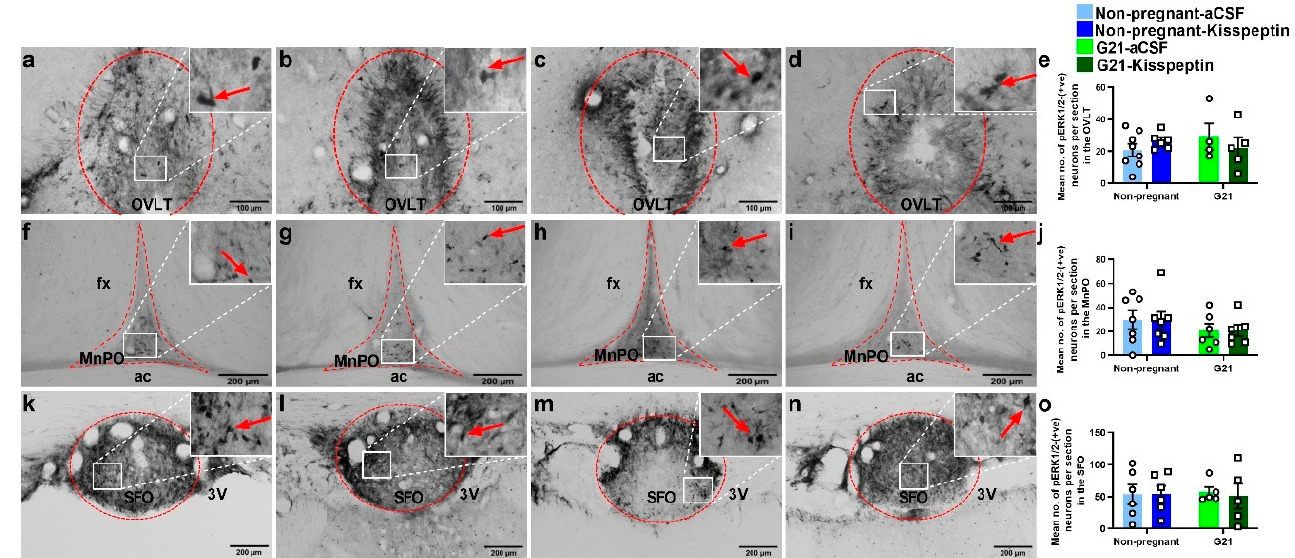
Figure 7. Kisspeptin does not affect pERK1/2 expression in OVLT, MnPO or SFO neurons of non- pregnant and G21 rats. Photomicrographs of coronal sections containing OVLT ( a – d ), MnPO ( f – i ) and SFO ( k – n ), within the red dotted area, showing pERK1/2-positive neurons in non-pregnant rats ( a , b , f , g , k , l ) and G21 rats ( c , d , h , i , m , n ) after ICV administration of aCSF ( a , c , f , h , k , m ) or kisspeptin (2 µ g in 2 µ L; b , d , g , i , l , n ). Red arrows point to representative pERK1/2 labelling. Mean ( ± SEM)